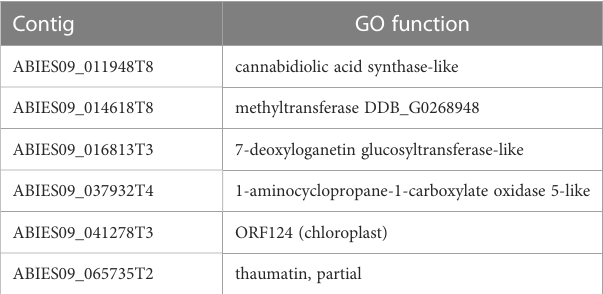
TABLE 4 Overlapping contigs between the fi xed SNPs between N and R individuals and the up-regulated genes in N individuals. Contig GO function